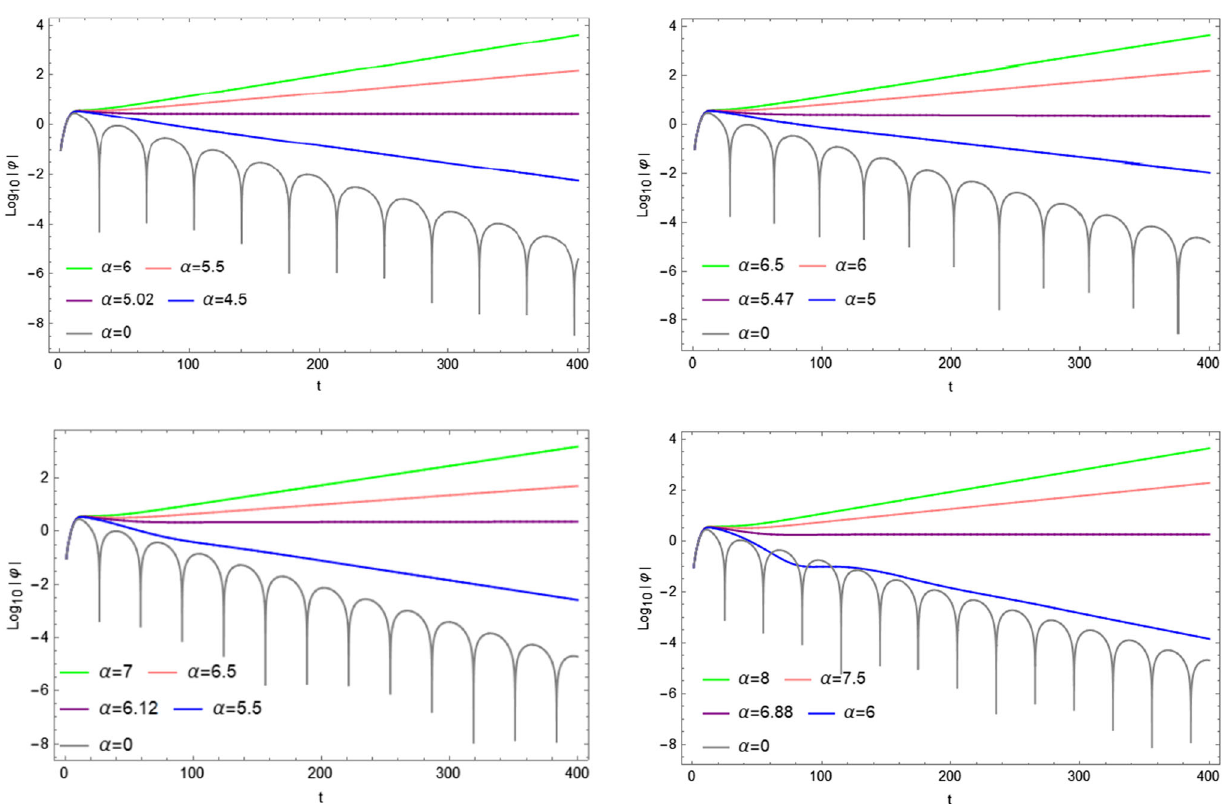
Fig. 8 The dynamical evolution of massive scalar field in log plot. The upper-left, upper-right, lower-left and lower-right plots correspond to m = 0 . 2 , 0 . 3 , 0 . 4 and 0 . 5 respectively